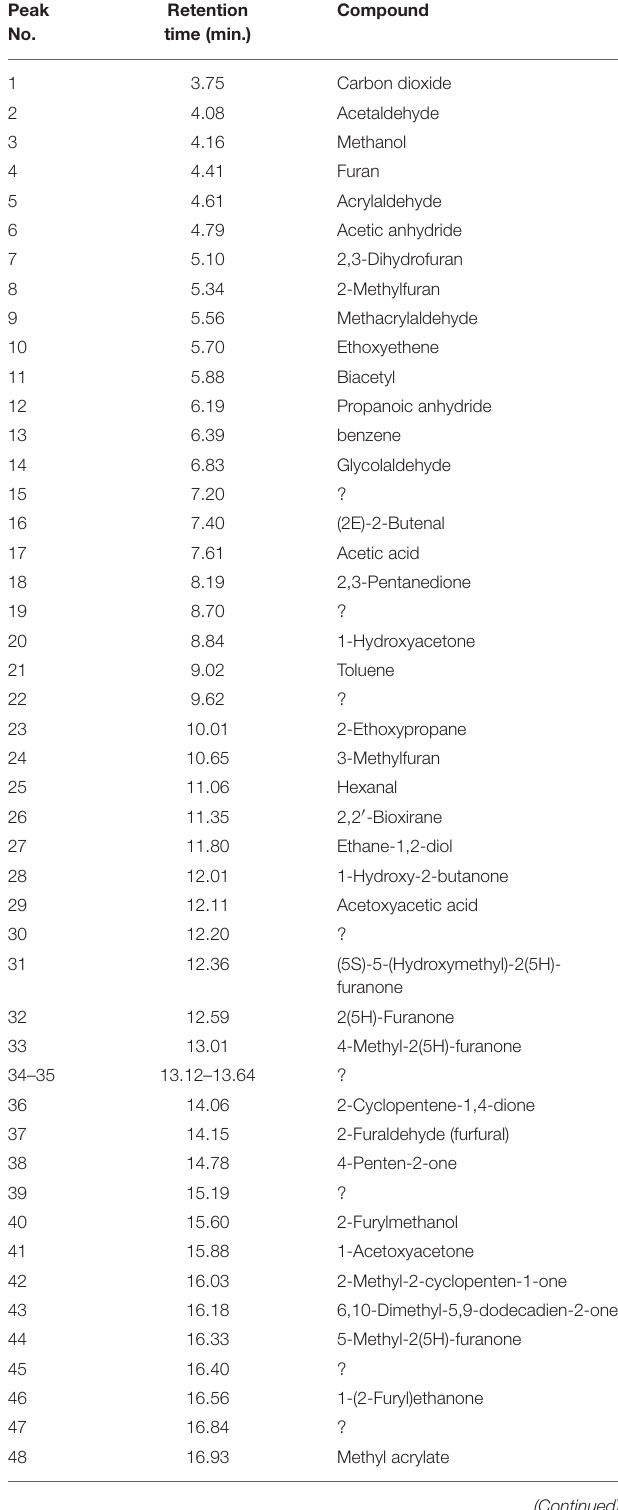
TABLE 5 | Vapor-phase pyrolysis product compounds identified using pyrolysis gas chromatography mass spectrometry (Py-GC/MS) in pure switchgrass, 2PN, and 6PN biomass samples under identical pyrolysis